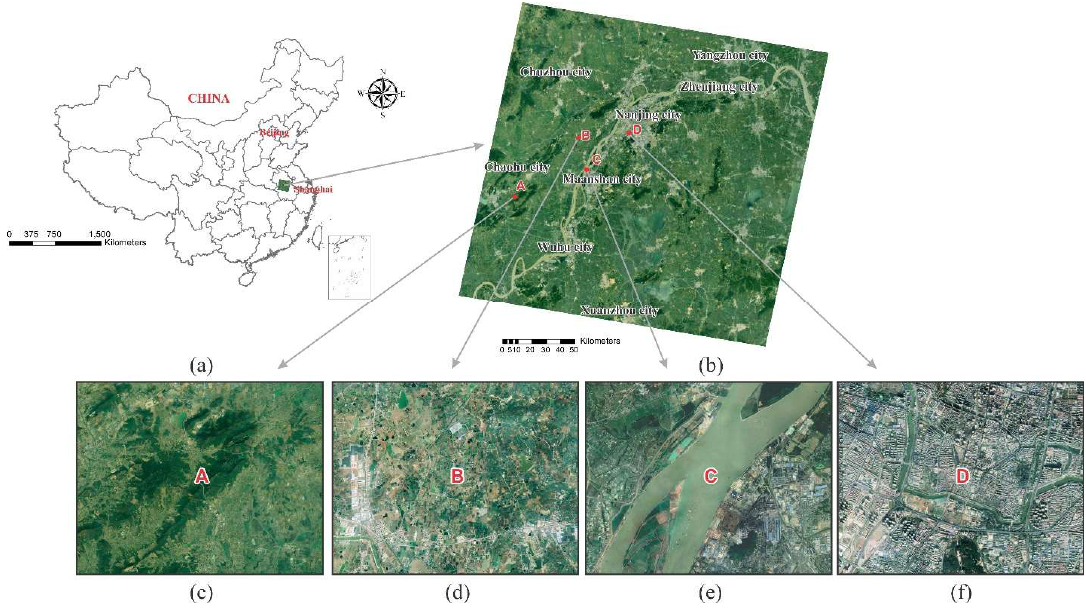
Figure 2. Landsat5 TM images used for validation of the approach, with ( a ) showing the geographical location of the image in East China, ( b ) TM image of Nanjing region in the Low Reach Basin of the Yangtze River, the largest river in China. The ground surfaces of mountain ( c ), plain ( d ) water ( e ) and city ( f ) area used for the experiments to validate the approach.